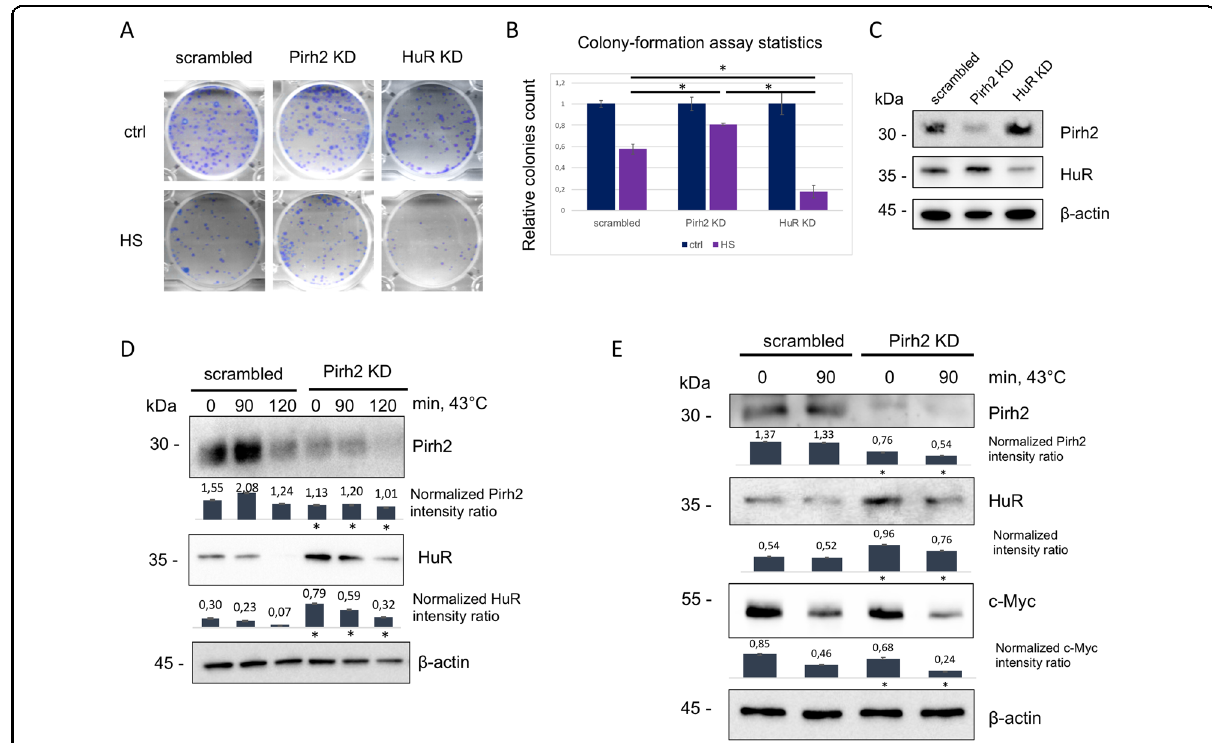
Fig. 4 Pirh2 affects HuR stability, cellular survival, and cell cycle in HeLa cells during heat-shock response. A Knockdown of Pirh2 leads to an increase of HeLa cell viability after heat-shock exposition. Colony-formation assay of Pirh2 knockdown (Pirh2 KD), HuR knockdown (HuR KD), and control (scrambled) HeLa cells in normal condition (ctrl) and after 45 °C incubation for 3 h (HS). The test was performed in triplicates. B Statistical analysis of colony-formation assay. Error bars indicate ±SEM. C Western blot analysis demonstrating protein levels of Pirh2 and HuR in Pirh2 knockdown (Pirh2 KD), HuR knockdown (HuR KD), and control (scrambled) HeLa cells. D Pirh2 destabilizes HuR under heat shock. Western blot analysis of HuR level in HeLa cells with Pirh2 knockdown (Pirh2 KD) and control HeLa cells (scrambled) after incubating at 43 °C for 90 and 120 min. The normalized intensity ratios were calculated as ratios between the signals of proteins analyzed and the corresponding actin bands on the basis of three measurements. Error bars indicate ±SD. * p ≤ 0.05 vs. scrambled for the corresponding time points according to Student ’ s t -test. E Pirh2 stabilizes c-Myc protein in HeLa cells. Western blot analysis of Pirh2, HuR, and c-Myc levels in HeLa cells with Pirh2 knockdown (Pirh2 KD) and control HeLa cells (scrambled), both in normal condition and after incubating at 43 °C for 90 min. The normalized intensity ratios were calculated as ratios between the signals of proteins analyzed and the corresponding actin bands on the basis of three measurements. Error bars indicate ±SD. * p ≤ 0.05 vs. scrambled for the corresponding time points according to Student ’ s t